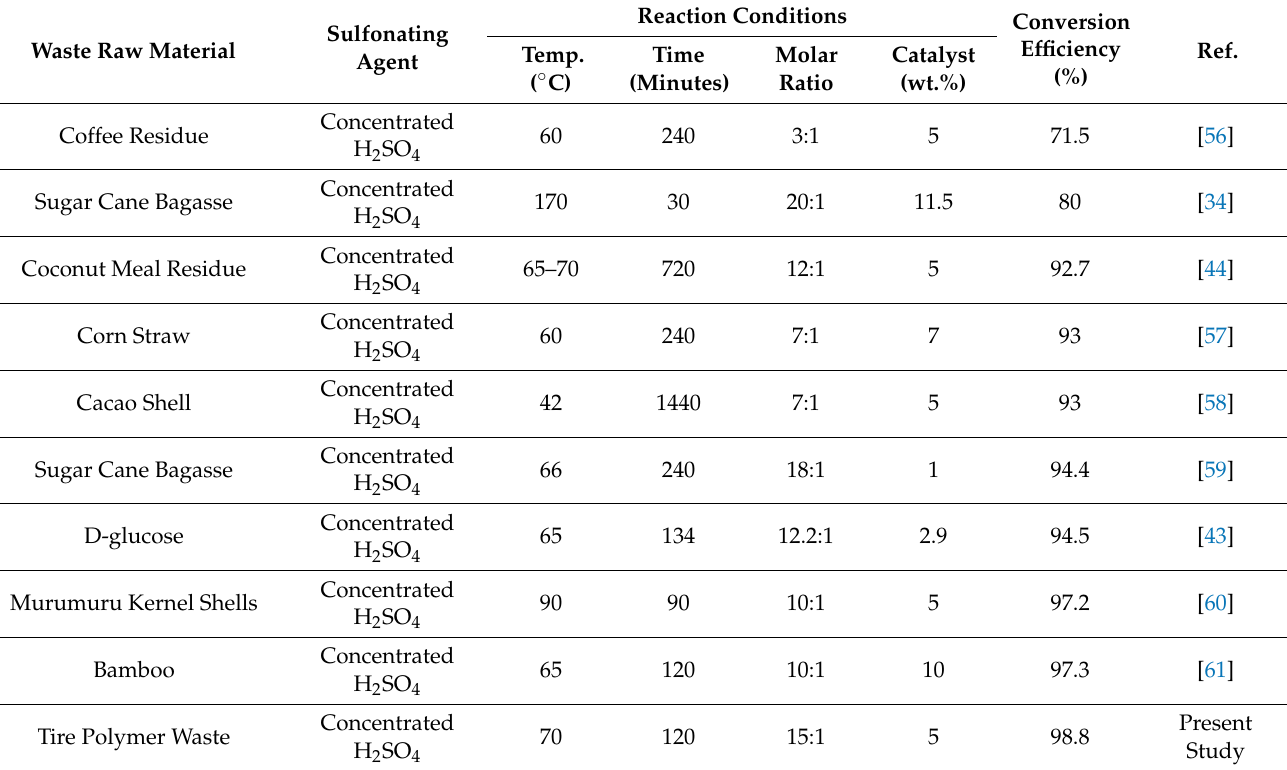
Table 1. Activity comparison of various waste-derived carbon-based sulfonated catalysts for biodiesel synthesis.